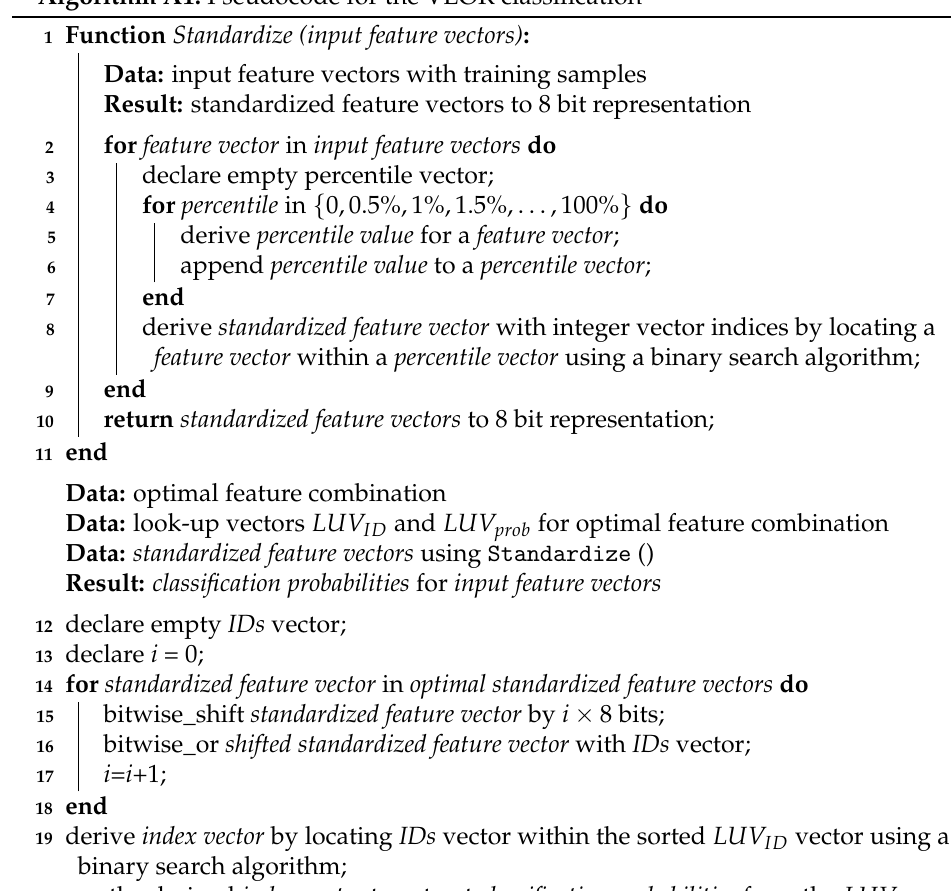
Algorithm A1: Pseudocode for the VEOR